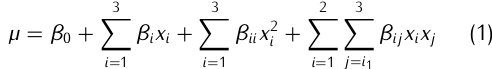
◦ at 50-60 C for 24 h. Dry algal powder was obtained by treating the algal biomass with liquid Nitrogen and rup- turing it in the laboratory grinder. Two grams of dry